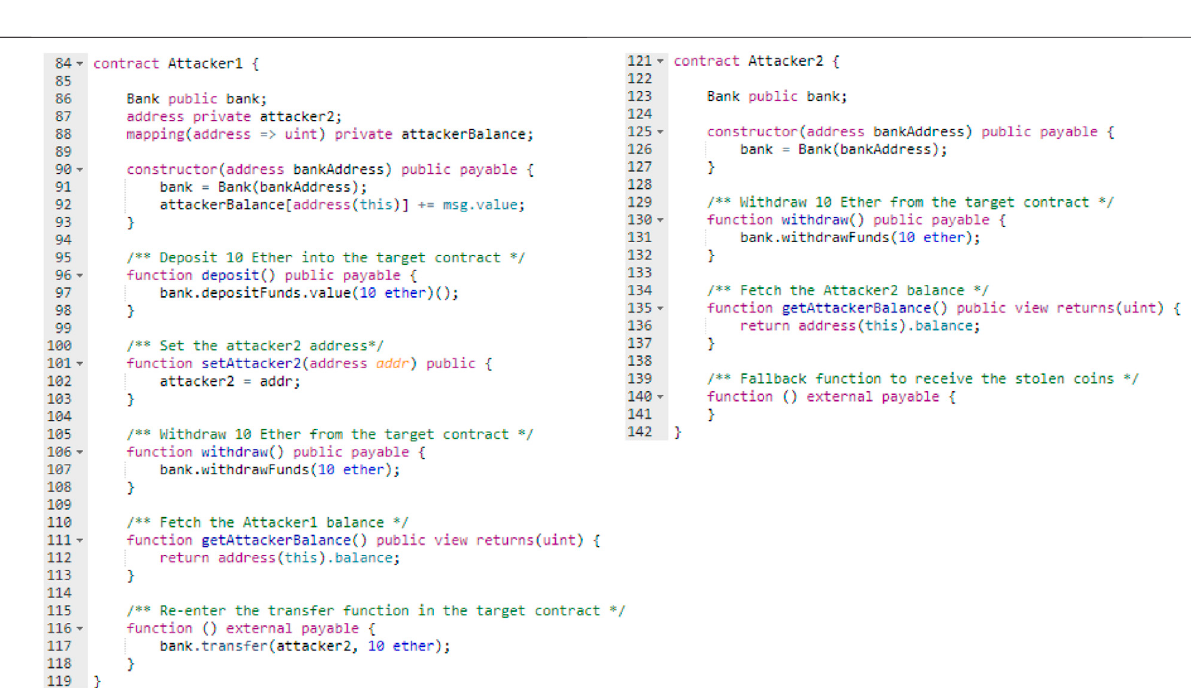
Frontiers in Computer Science |